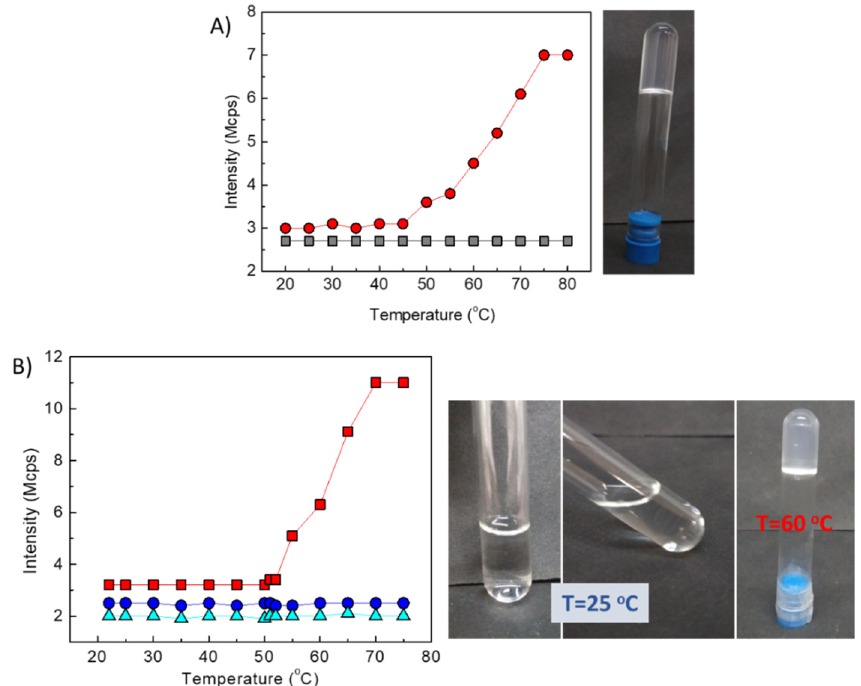
Figure 2. Light scattering intensity at 90 o as a function of temperature of polymer aqueous solutions at various pH with C p = 1 wt%: ( A ) PLL, ( ○ ) pH 10.6 and ( □ ) pH 7, the photo illustrates a freestanding transparent gel of the solution at pH 10.6, and 65 °C, and ( B ) PLL-g-NIPAm29, ( □ ) pH 10.8, ( ○ ) pH 8.7, ( ∆ ) pH 7.4, the photo illustrates transparent solutions at pH 10.8, 25 °C and a turbid free-standing gel at pH 10.8 and 60 °C.